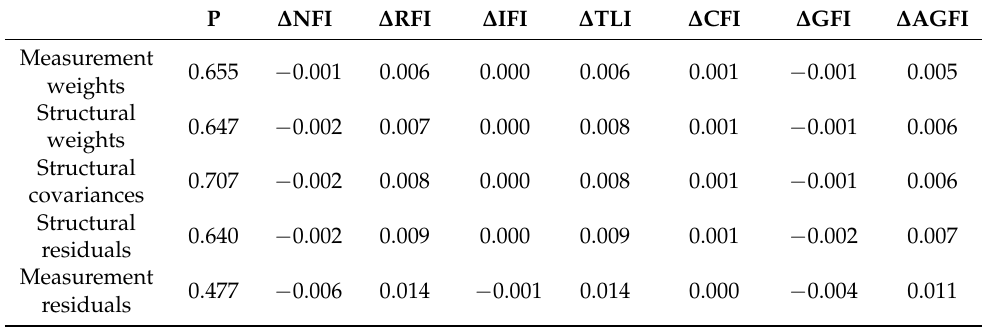
Table 9. Results of indicators of multi-group SEM mode invariance by